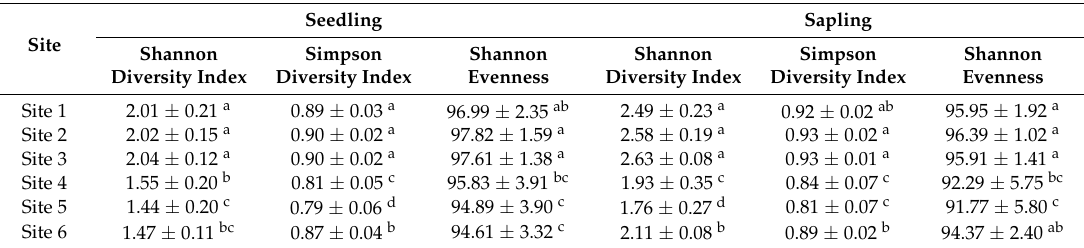
Table 5. Different diversity indices of seedlings and saplings among six study